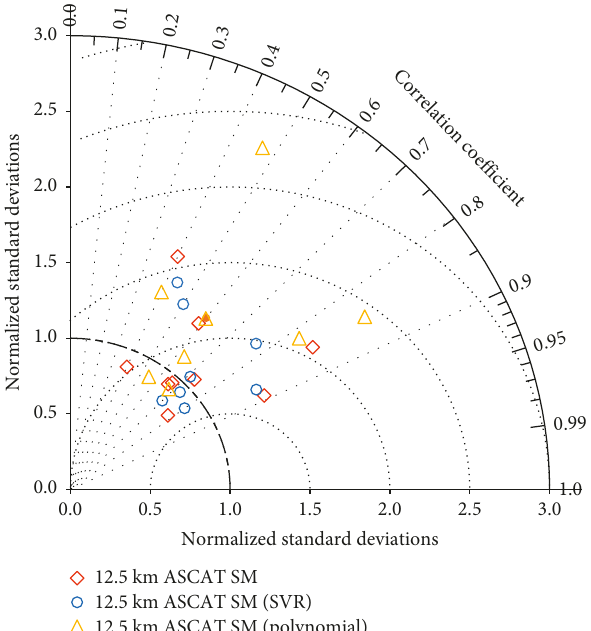
Figure 6: Taylor diagram (correlation coefficient, normalized standard deviation, and root mean square error) of each SM measurement from 12.5km ASCAT, 1km ASCAT with SVR, and 1km ASCAT SM with polynomial.